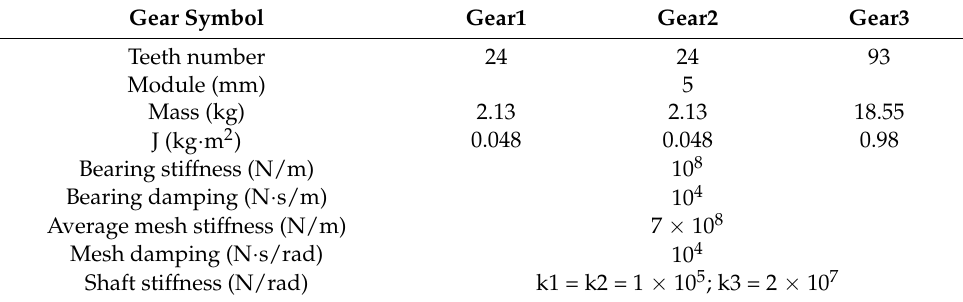
Table 1. Parameters of the gear